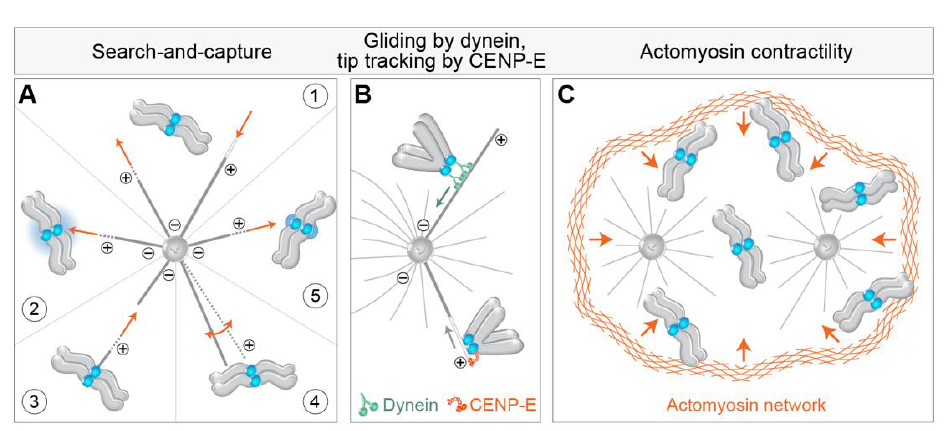
Figure 2. Mechanisms of kinetochore search-and-capture and gathering on the spindle. ( A ) (1) Chro- mosome alignment involves the microtubule search for kinetochores (blue circles) by dynamic growth (dotted lines and orange arrow pointing away from the microtubule tip) and shrinkage (empty white line and orange arrow pointing to the microtubule tip). The efficiency of search-and- capture is facilitated by different additional mechanisms, including (2) biased microtubule growth towards the kinetochore via the Ran-GTP gradient (blue gradient), (3) microtubule growth from the kinetochore, (4) microtubule pivoting (orange curved arrow) around the spindle pole, and (5) ki- netochore expansion before microtubule capture. Microtubule plus and minus ends are denoted by encircled + and − signs. The spindle is represented as monopolar for simplicity. ( B ) The successful capture event for the polar chromosome is followed by the gliding of the kinetochore laterally along the microtubules mediated by dynein walking toward the minus end of microtubule (top) or by kinetochore tracking of the depolymerizing microtubule tip (empty white line) by CENP-E. The green arrow represents the direction of dynein walking, and the grey arrow represents the direction of microtubule depolymerization. ( C ) Chromosome gathering on the spindle is also facilitated by the synchronous actomyosin contractility (illustrated with orange arrows) during early prometaphase, independently of microtubules.